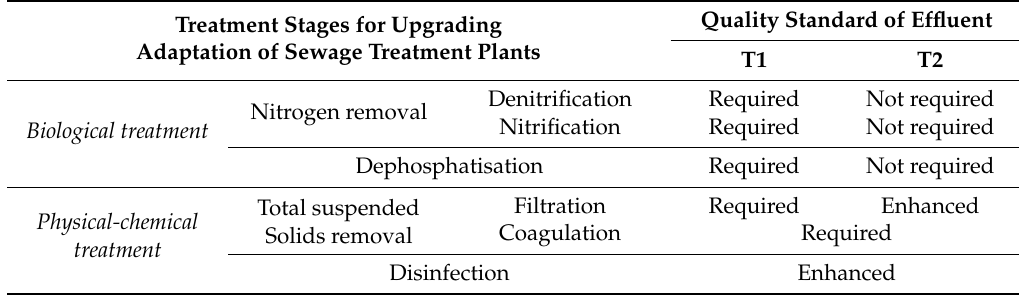
Table 3. Treatment stages and processes necessary for the achievement of T3 quality standards.